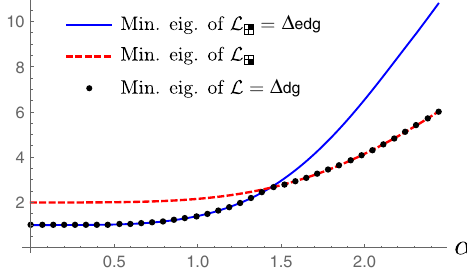
FIG. 3. Plot of the effective dissipative gap Δ eigenvalue of L  with smallest real part, and the dissipative gap Δ versus α for the Lindbladian with jump operator dg F ¼ a 2 − α 2 . One can see that Δ